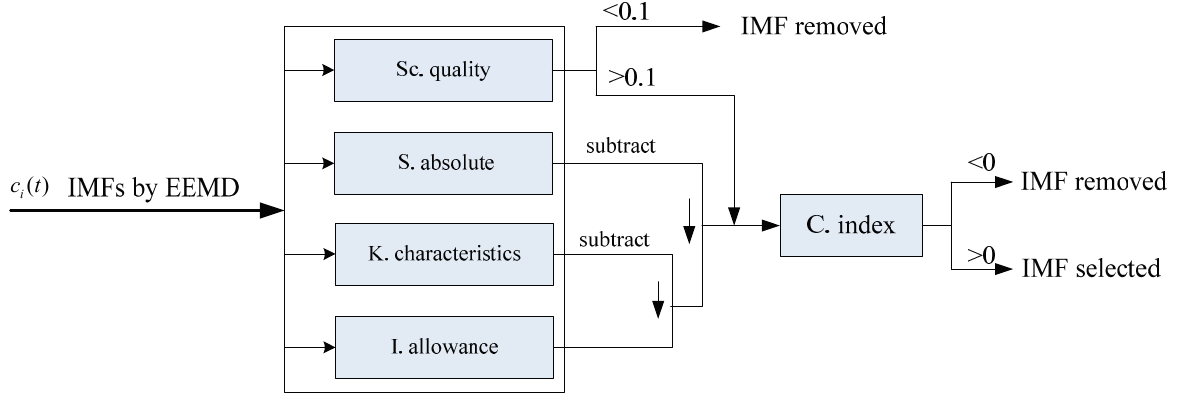
Figure 1. IMFs’ confidence index algorithm computational